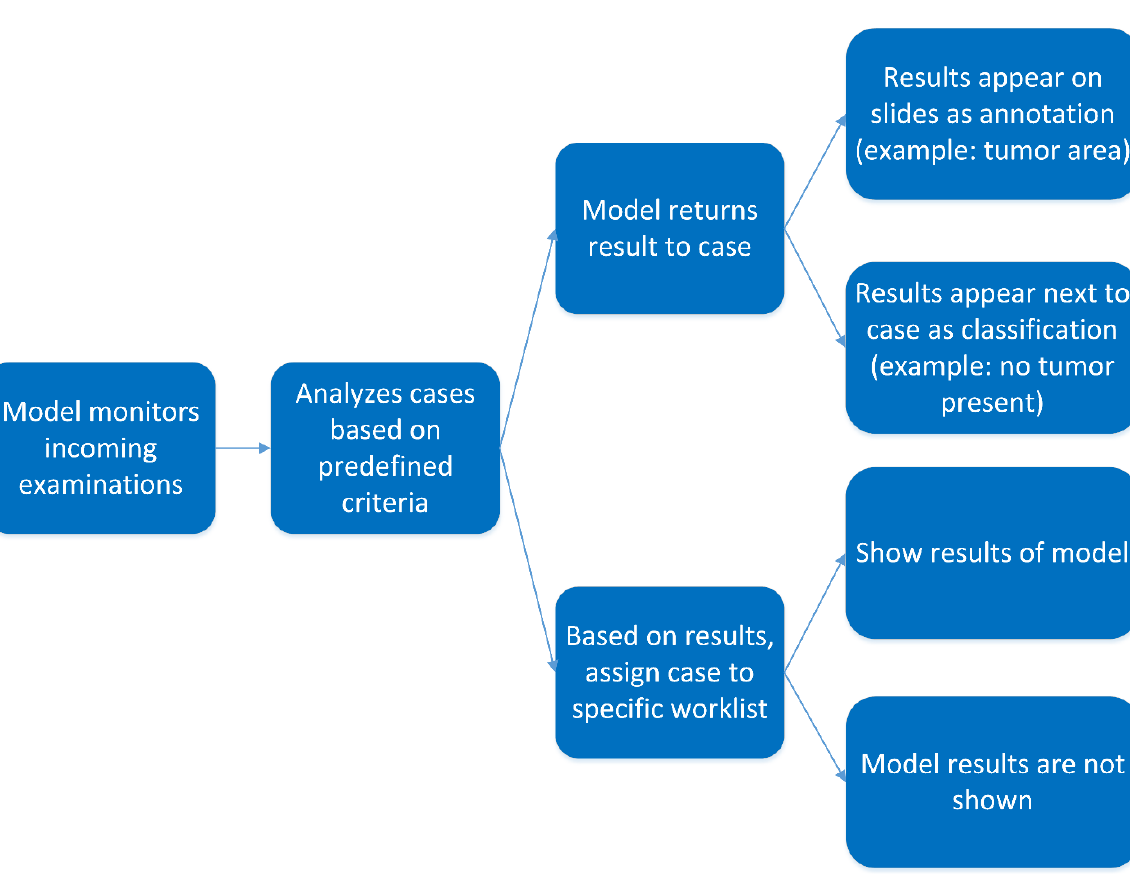
Figure 2. Flowchart showing a workflow for on-demand, interactive processing.